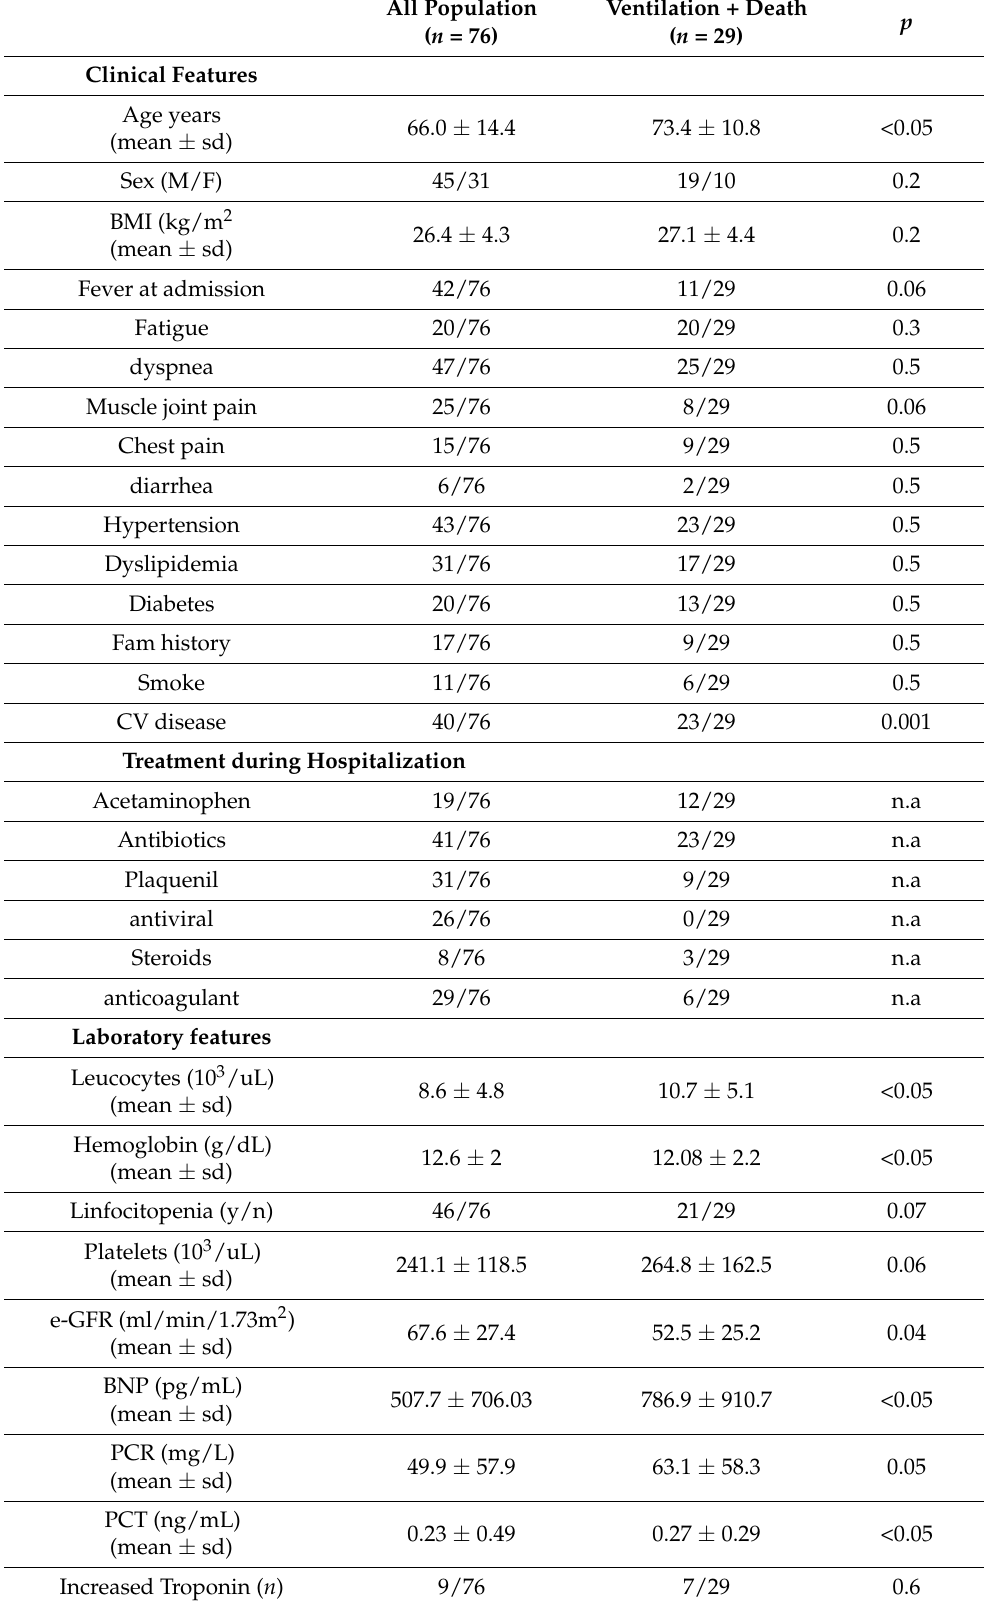
Table 1. Patient population demographic, clinical and laboratory characteristics, treatment and CT